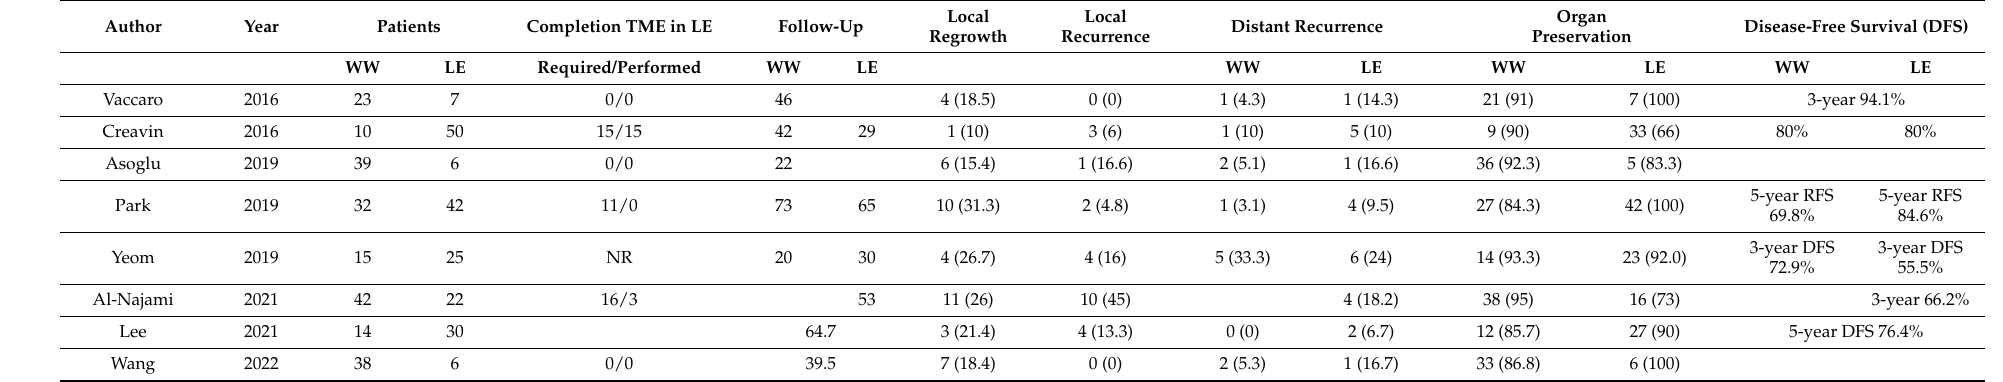
Table 2. Number of patients, and long-term